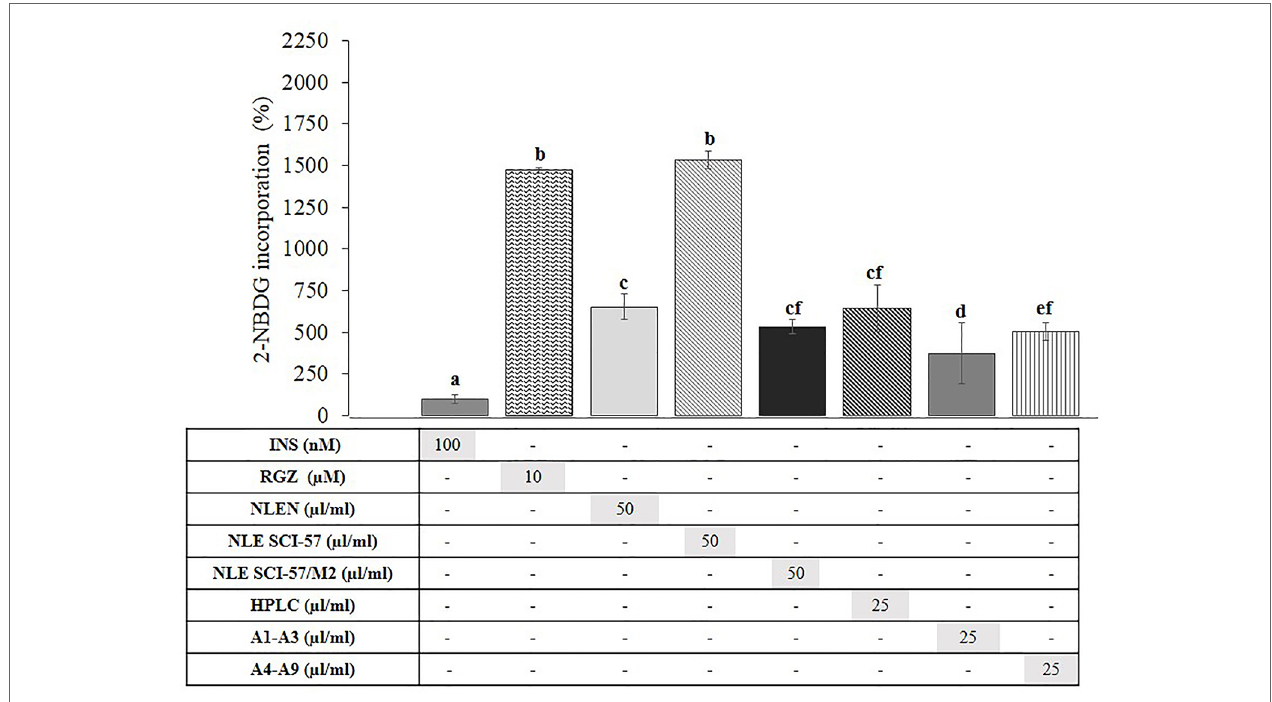
FIgUrE 11 | Effect of NLEN, NLE SCI-57, NLE SCI-57/M2 and purified samples on 2-NBDG uptake in 3T3-L1 adipocytes. Mature 3T3-L1 adipocytes were incubated as described (Zapata-Bustos et al., 2014b). Control treatments were incubated with insulin 100 nM (INS) or rosiglitazone 10µM (RGZ). Results are presented as the mean ± S.D. of experiments in quadruplicate. Lowercase letters indicate significant differences according to the Mann-Whitney U test ( p ≤ 0.05). HPLC: Purified NLE-SCI-57 sample (A2–A7 fractions) analyzed by HPLC ( Figure 6g ). A1–A3 and A4–A9: NLE-SCI-57/M2